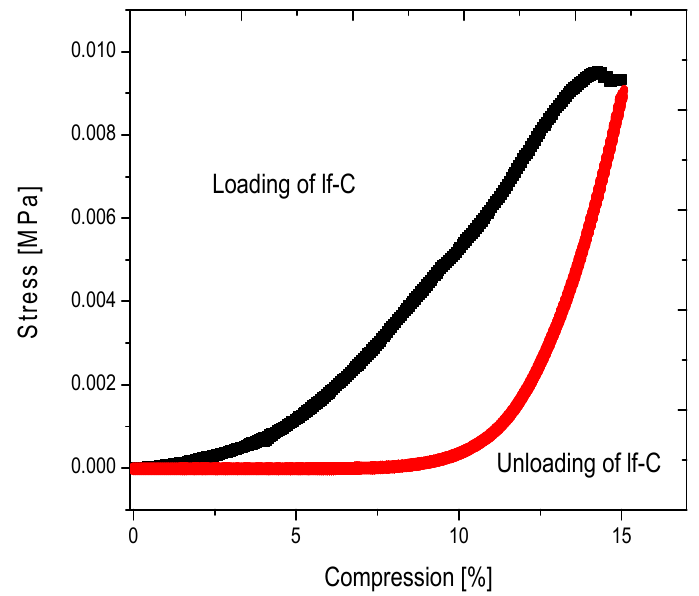
Figure 10. Loading and unloading curves of the low-flexible carbon aerogel. The large hysteresis speaks for the deformation of the sample.